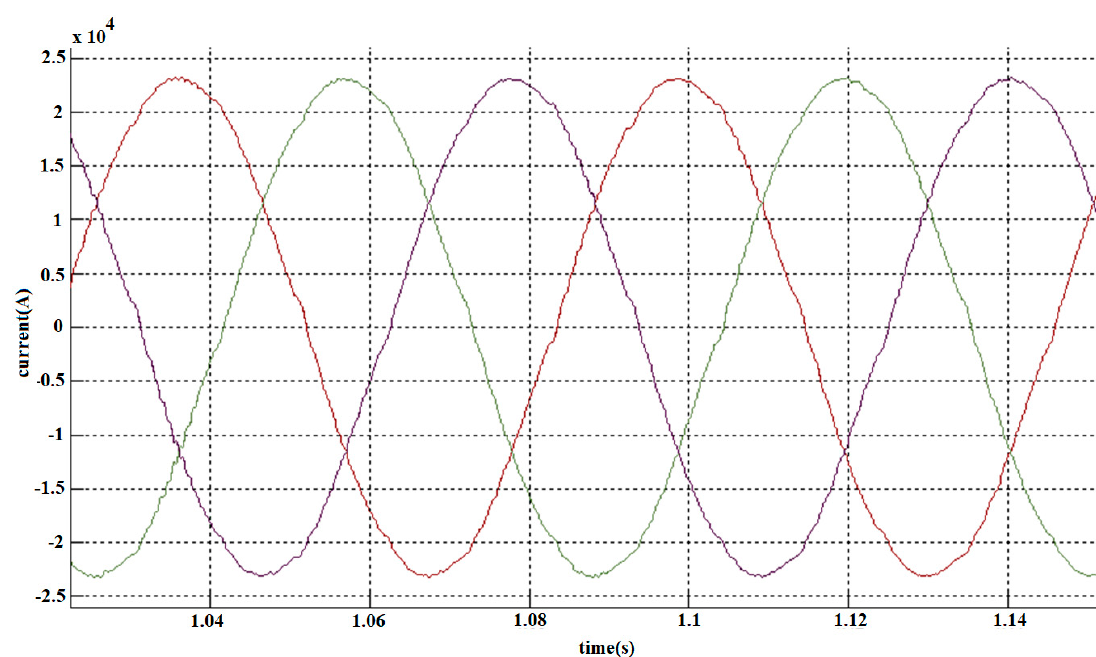
Figure 24. Output current waveform of wind farm.